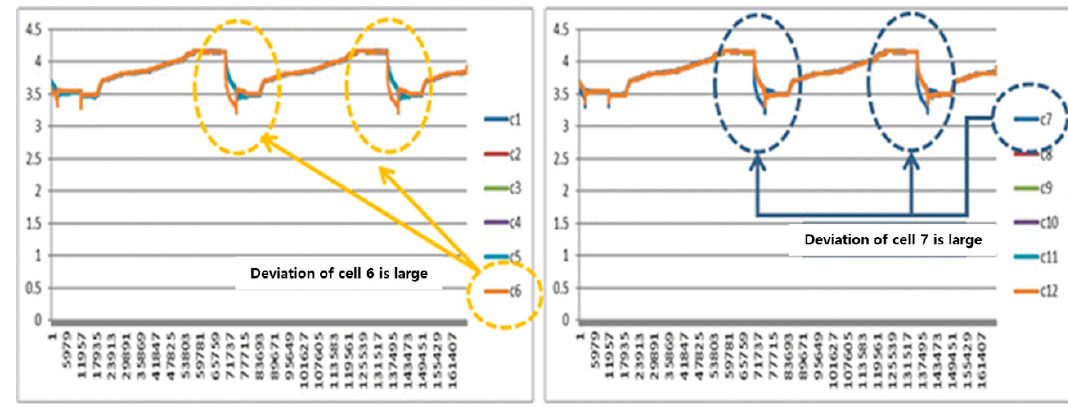
Figure 20. Comparison of the voltage deviation of each battery cell.